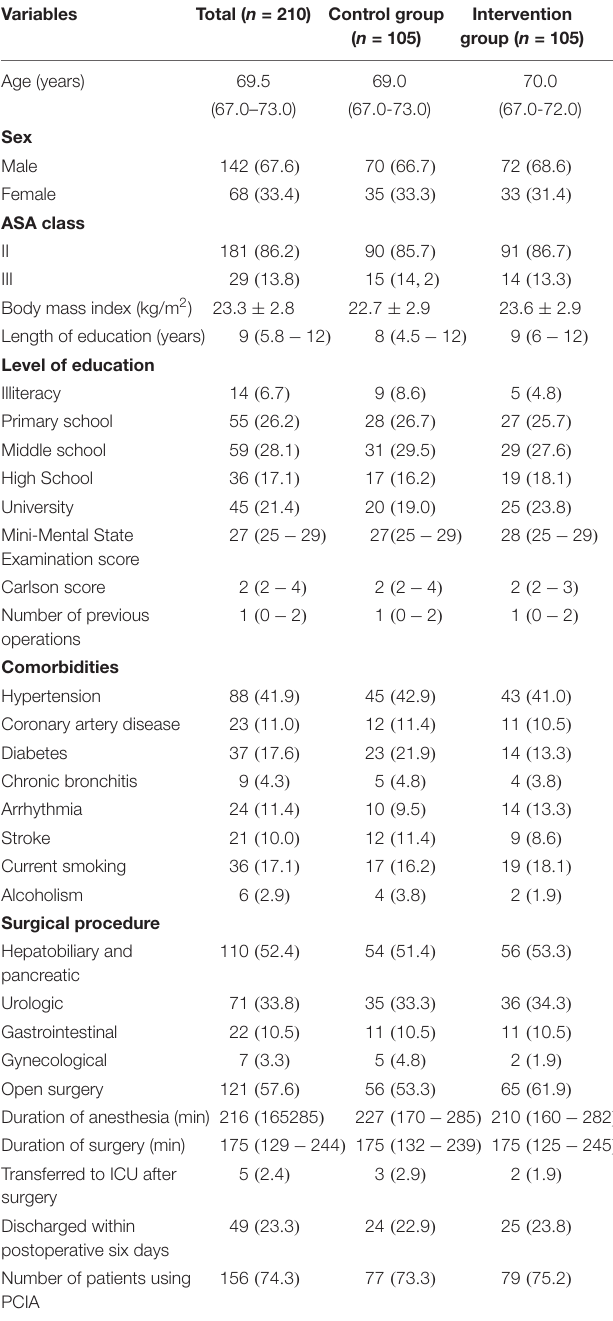
TABLE 1 | Baseline characteristics and surgical details of the intention-to-treat